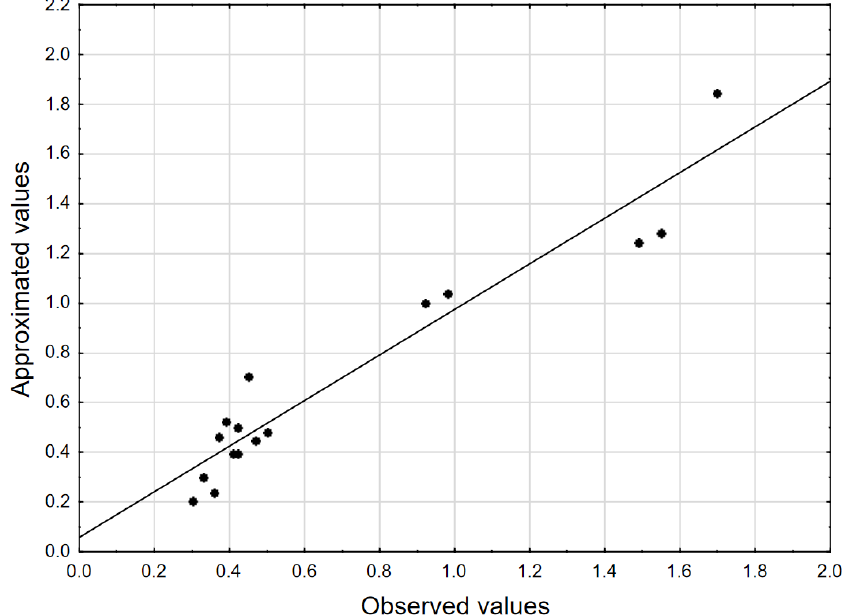
Figure 2. Approximated vs. observed values (Zn, mg/L, 3 value, 1 block, 16 experiments, MS = 0.0320, R 2 = 0.9173, R 2adj = 0.8622).